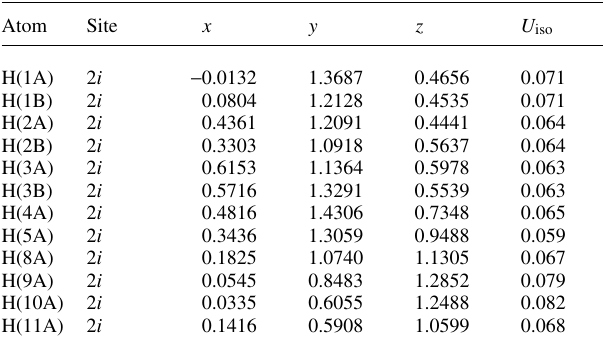
Table 2. Atomic coordinates and displacement parameters (in Å 2 )